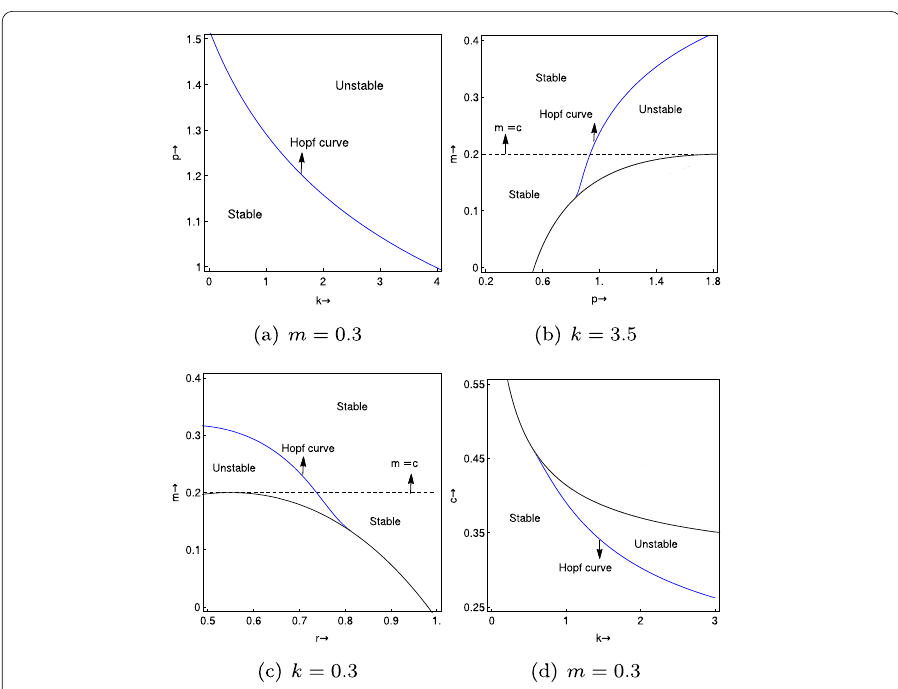
Figure 10 Two-parameter bifurcation diagram for system (2.4a)–(2.4b) with different choice of parameter values, the blue curve represents Hopf bifurcation curve, the black curve represents determinant zero (below in ( b ), ( c ) and above in ( d ), system (2.4a)–(2.4b) has no interior equilibria), and the black dashed curve represents m =